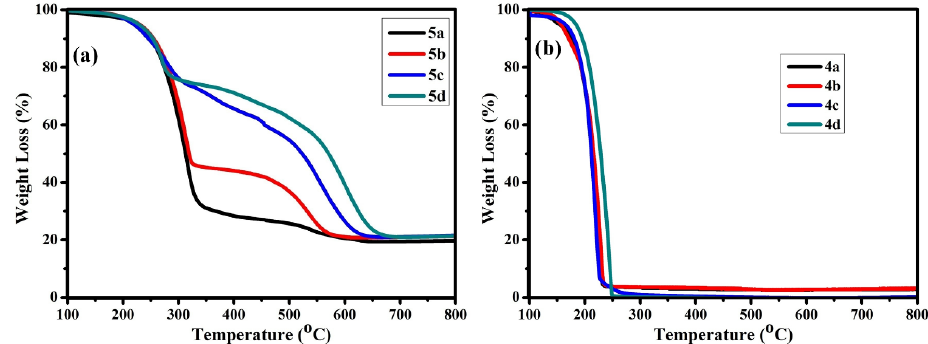
Figure 2. TGA curves for ( a ) B-L MILs and ( b ) precursors with chloride anion obtained at a heating rate of 5 °C min − 1 .